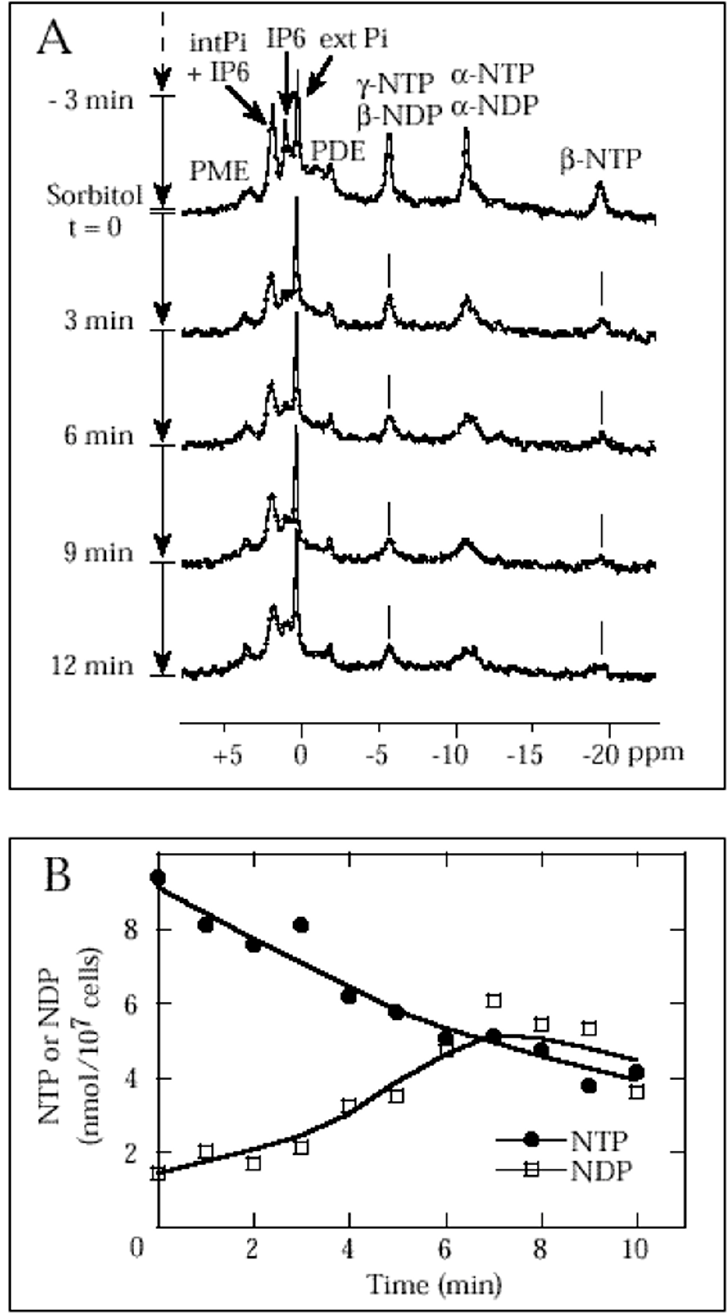
In vivo 31 P-NMR analysis of the effect of osmotic shock on phosphorylated metabolites in Dictyostelium cells (A) The experiments were performed as described for the determination of cytosolic pH by 31 P-NMR using MEP as probe. Only the spectral region (+5 to -20 ppm) corresponding to phosphorylated metabolites is shown. (B) Temporal evolution of intrac- ellular nucleoside di- and triphosphate content during hyperosmotic shock in Dictyostelium cells. The relative intracellular NTP content was calculated from the area of the P-NTP peak at about -20 ppm and the NDP content was deduced from the area of the ( β -NDP + γ NTP) peak at about -5 ppm. The NTP and NDP content (nmol/10 7 cells) before hyperosmotic shock (values at T = 0) were measured on perchloric acid extracts. Abb.: PME, phosphomonoesters; PDE, phosphodiesters; cytPi, extPi, cytosolic and extracellular P i ; NTP, NDP, nucleoside tri- and diphosphate; IP6, inositol